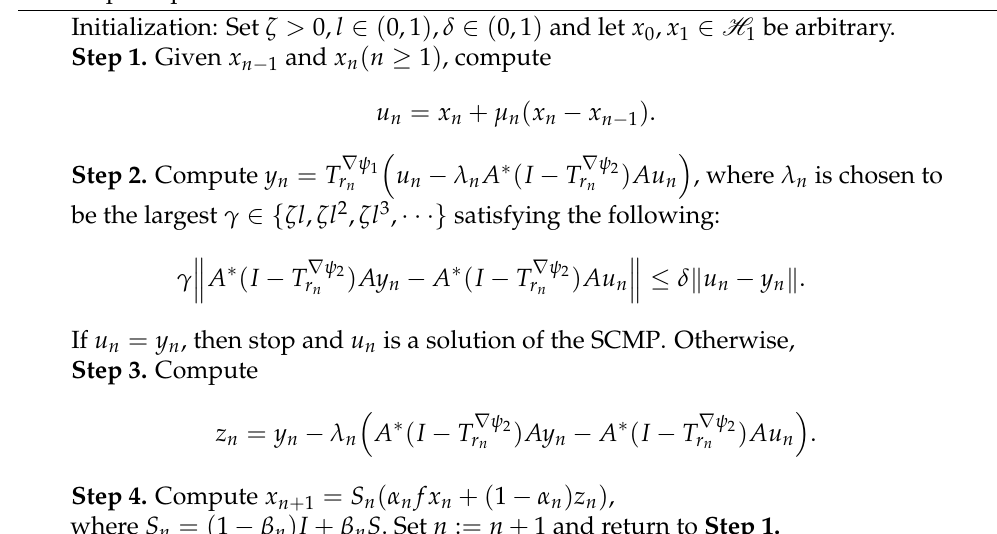
Algorithm 5: The hybrid inertial accelerated algorithm for the SCMP and the fixed point